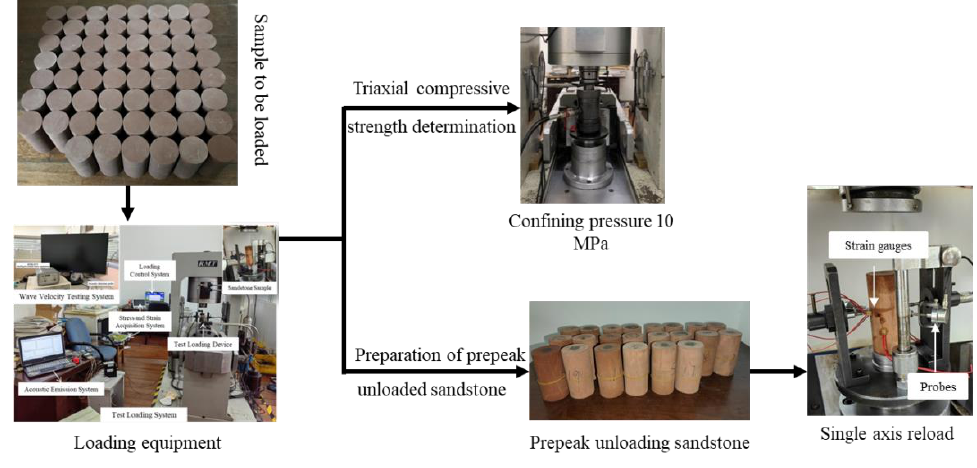
Figure 1. Experimental flow chart.